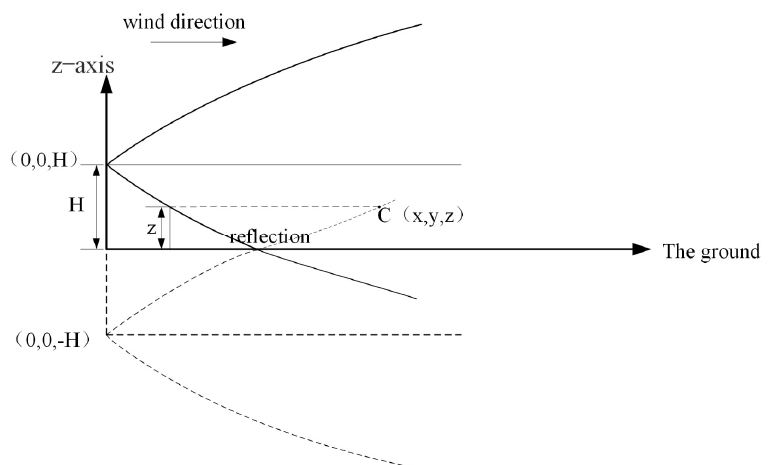
Figure 2. The sketch map of reflection.